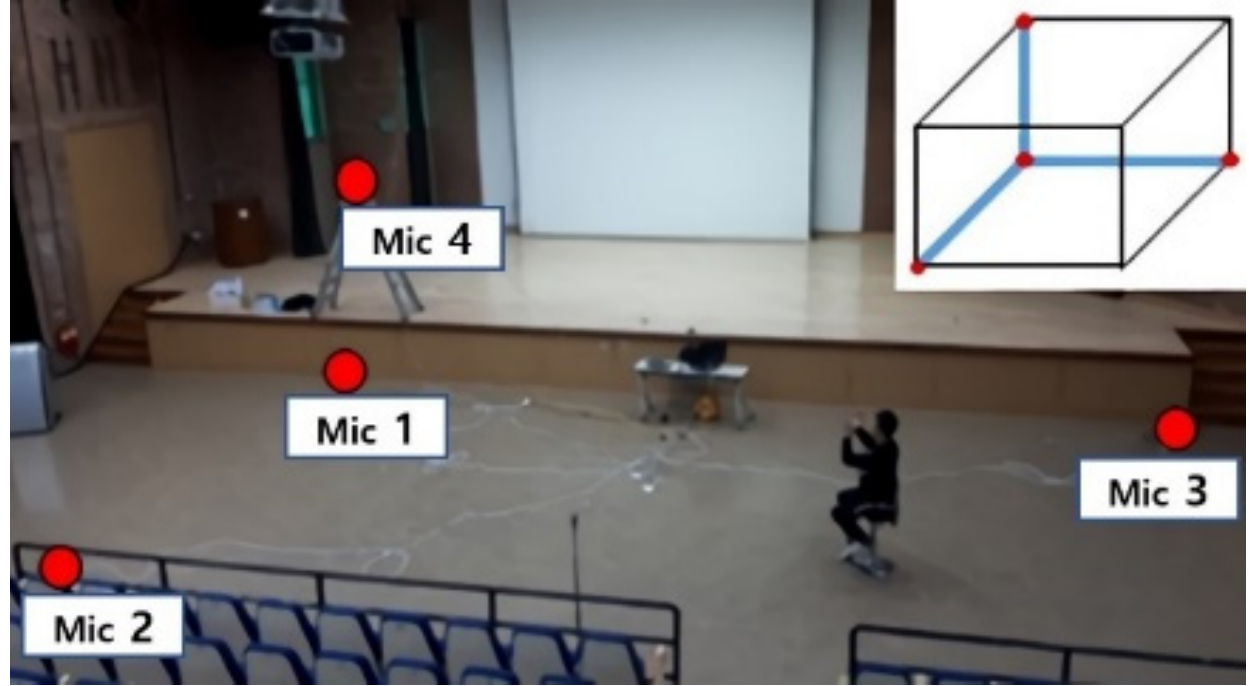
Figure 7. Preliminary tests with a right-angled pyramidal array.